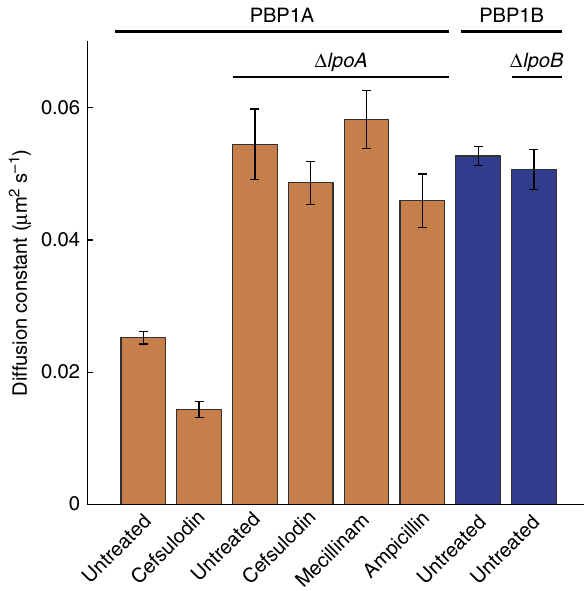
Figure 3 | PBP1A dynamics and activity are regulated by LpoA in vivo . Apparent diffusion constants of PAmCherry-PBP1A molecules (orange) imaged in a strain deleted for lpoA (TKL242) and treated with cefsulodin, mecillinam, or ampicillin (100 m gml (cid:2) 1 each). Diffusion constants of PAmCherry-PBP1B molecules (blue) were determined with and without lpoB (strain TKL243). Error bars indicate the s.d. of 1,000 bootstrap